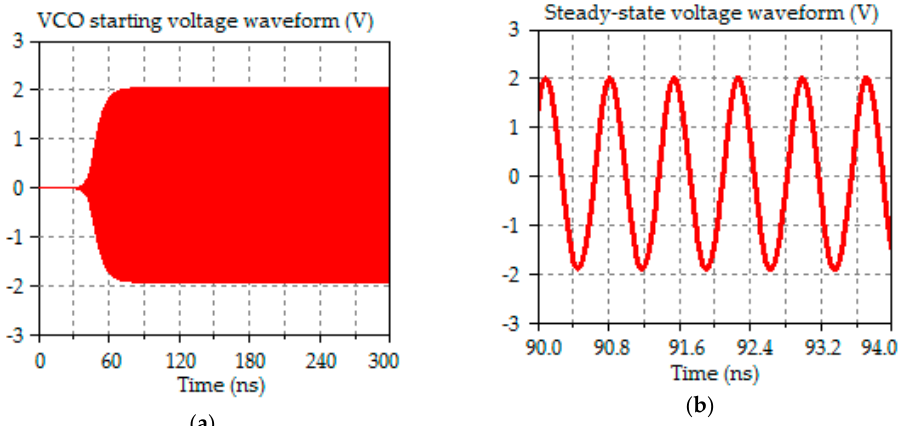
Figure 13. ( a ) VCO starting voltage waveform when V c = 25 V; ( b ) VCO steady-state voltage when V c = 25 V.